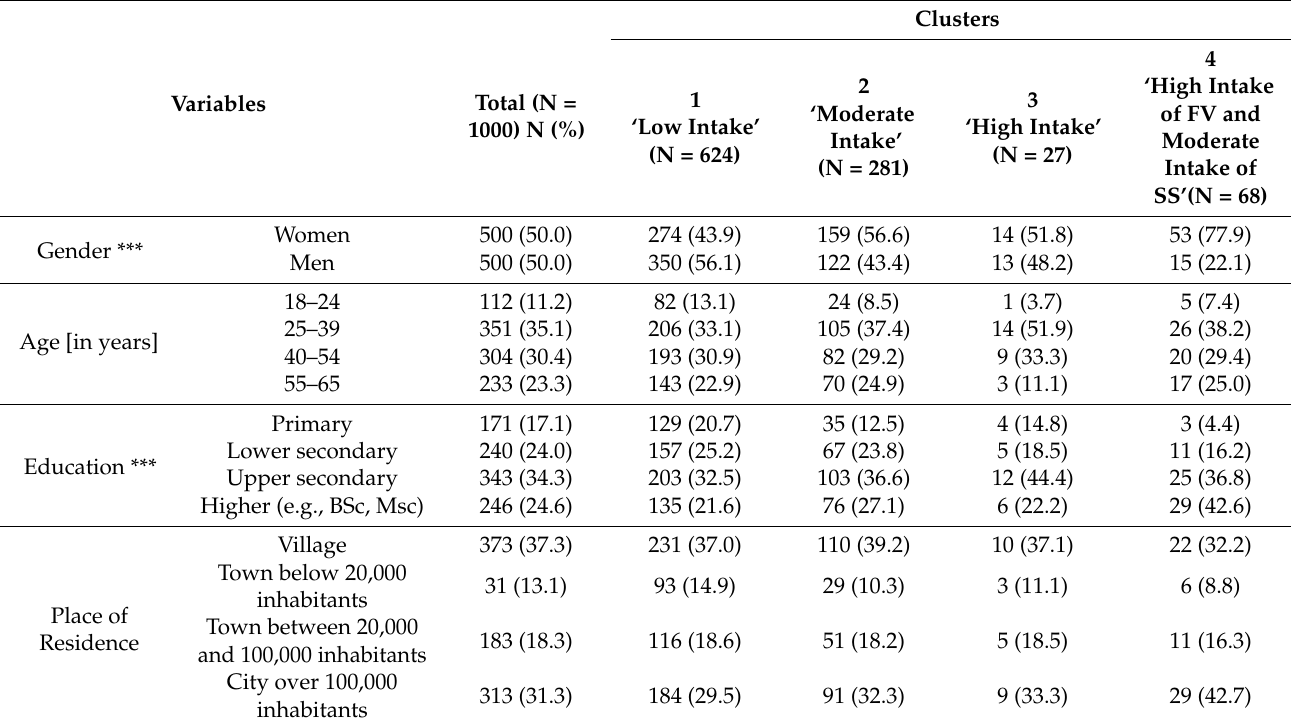
Table 1. Socio-demographic characteristics of the study sample.